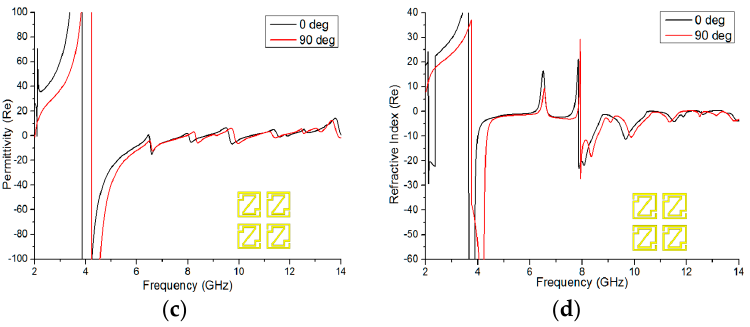
Figure 8. ( a ) 90-degree rotated 2 × 2 array geometry; the real magnitude of ( b ) the permeability; ( c ) the permittivity; and ( d ) the refractive index of the 90-degree rotated 2 × 2 array configuration.